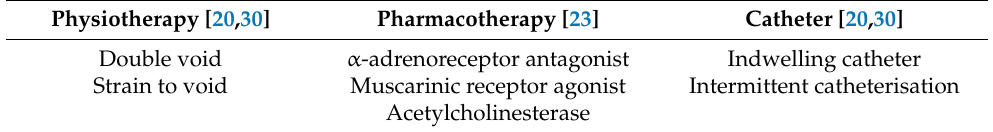
Table 5. Conservative management strategies for